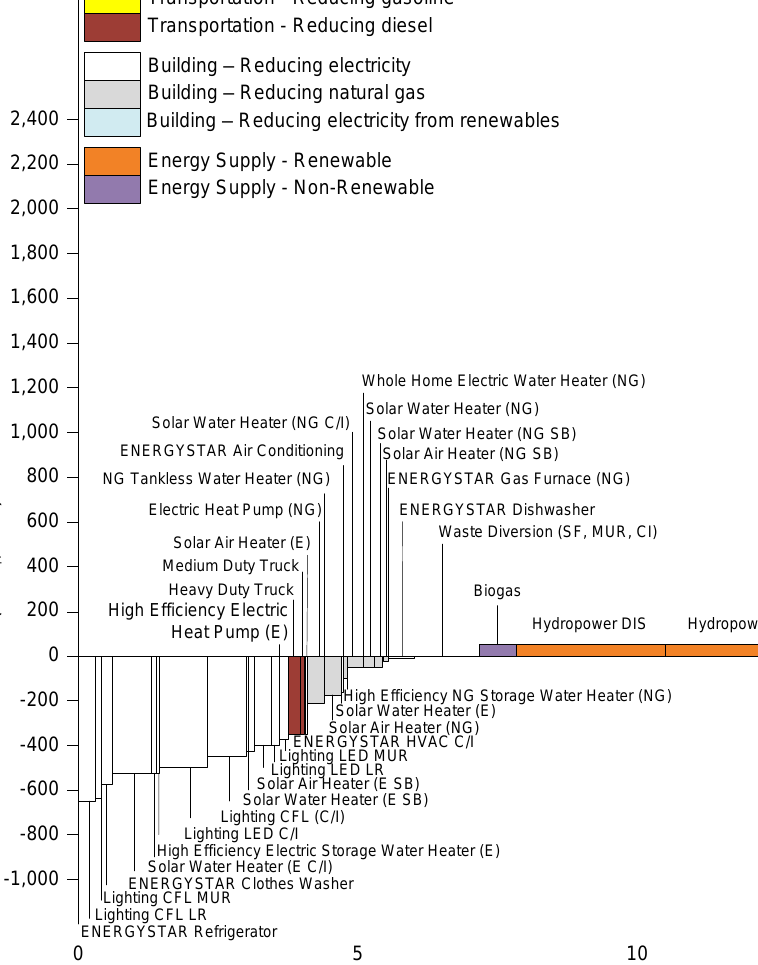
Figure 2. Toronto 2050 MAC curve showing mitigation measures by sector (R = Residential, LR = Low-rise, MUR = Multi-unit residential, SF = Single-family, SB = Small Business, C/I = Commercial/Institutional, NG = Natural gas, E = Electricity).